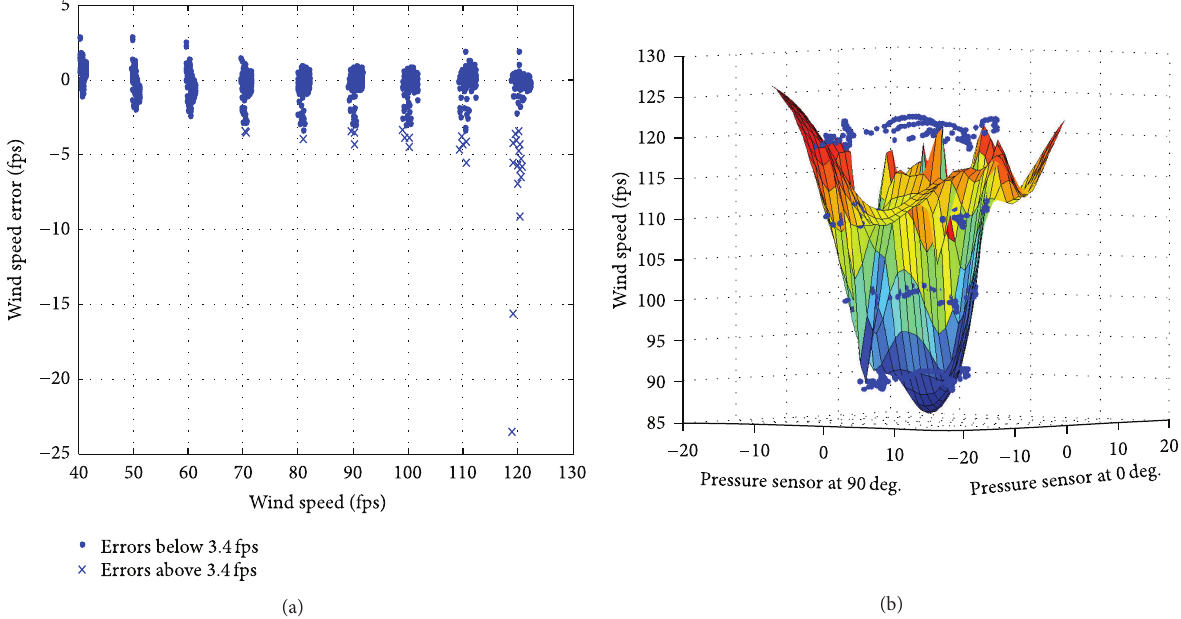
Figure 8: (a) Wind speed prediction on RALS tower data using just one network for wind speed given by (4). (b) Example surrogate of the wind speed hypercone in 2 dimensions.